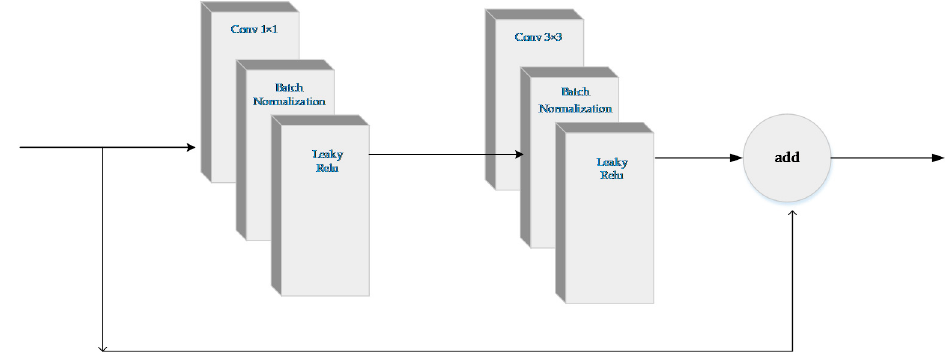
Figure 4. The structure of residual unit.